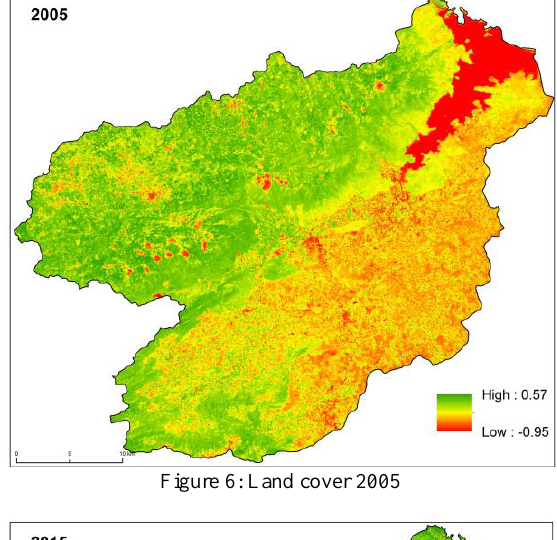
Figure 6: Land cover 2005